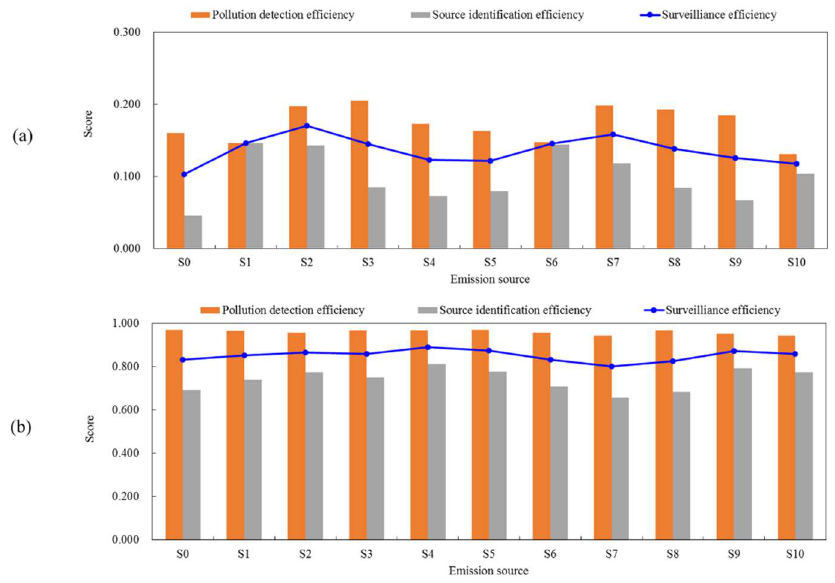
Figure 11. SE scores of the optimal AQMNs for different real sources in Scenario III. The numbers of monitors are ( a ) 2 and ( b ) 62.